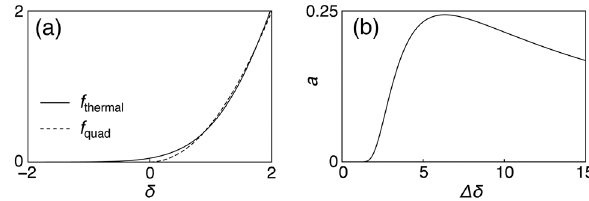
FIG. 14. Correspondence between the heuristic force depend- ence of Eq. (A19) and the theoretical expression of Eq. (A21). Here we use dimensionless units such that k ¼ 1 and k B T ¼ 1 . δ þ δ f δ Þ over the interval δ ∈ (a) Best fit of f 0 Þ to quad ð thermal ð the fit over an interval δ ∈ ½ − Δ δ = 2 ; Δ δ = 2 (cid:3) as a function of Δ δ